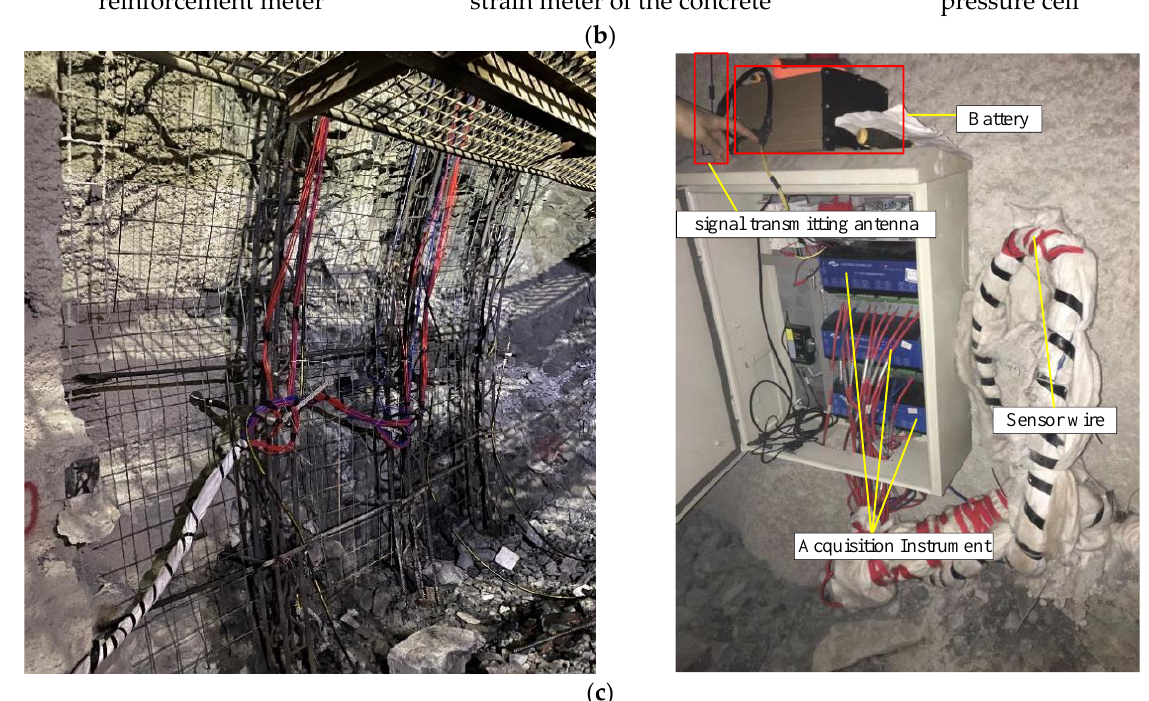
Figure 14. Measurement scheme of tunnel monitoring. ( a ) Schematic diagram of monitoring point layout; ( b ) monitoring sensor; ( c ) automated monitoring system. layout; ( b ) monitoring sensor; ( c ) automated monitoring